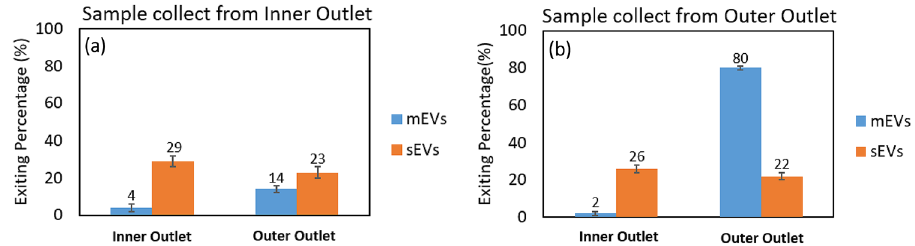
Figure 12. The results of recycling test done for the test B5R for the first-pass sample collected from the inner outlet (a) and the first-pass sample collected from the outer outlet (b) . n = 3, error bars = standard deviation